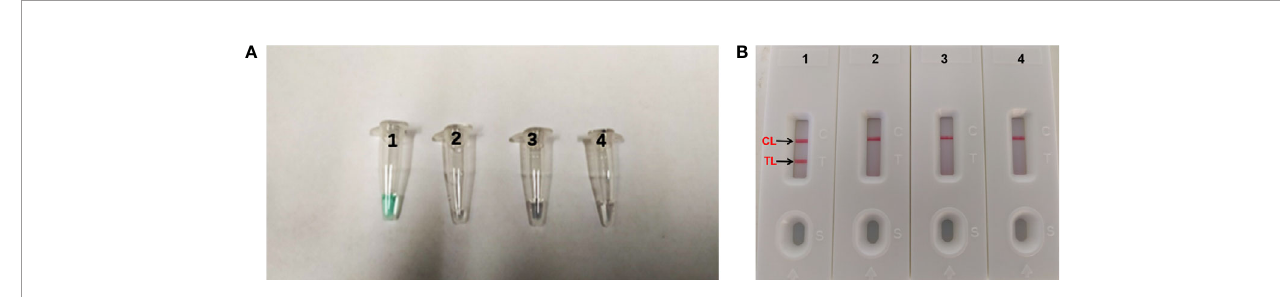
FIGURE 2 | Con fi rmation and detection of Aspergillus fumigatus -MCDA products. (A) Color change of A fumigatus -MCDA tubes; (B) (right), LFB applied for visual detection of A. fumigatus -MCDA products. Tube A1, positive ampli fi cation; tube A2, negative ampli fi cation ( Cryptococcus neoformans ), tube A3 negative ampli fi cation ( Candida albicans ), tube A4, negative control (DW); Biosensor B1, positive ampli fi cation; biosensor B2, negative ampli fi cation ( Cryptococcus neoformans ), biosensor B3, negative ampli fi cation ( Candida albicans ), biosensor B4, negative control